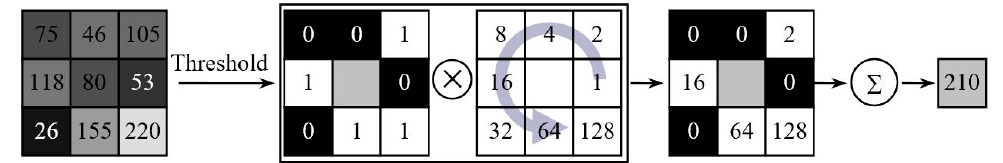
Figure 2. Example of converting LBP code to decimal.